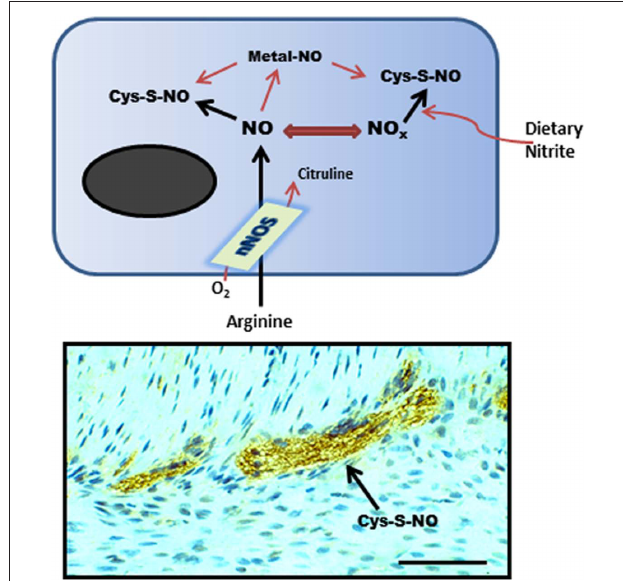
Figure 1 | Schematic representation (top) of nNOS activity generating SNO from l -arginine or from exogenous nitrite. This synthesis step may involve direct protein–protein interactions with nNOS or another SNO- synthase, transfer of a coordinated NO from a transition metal center, or by chemical reaction with a reactive nitrosium ion intermediate. (Bottom) shows anti-SNO immunoreactivity in the mouse small intestinal myenteric plexus (scale bar = 40 μm).